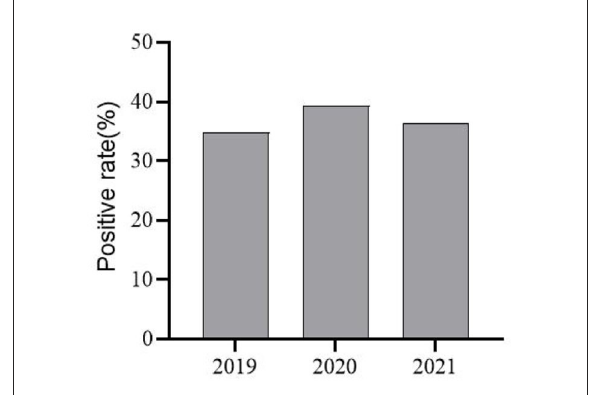
FIGURE3 PEDV Infection Positivity in selected areas of Shandong Province from 2019–2021.